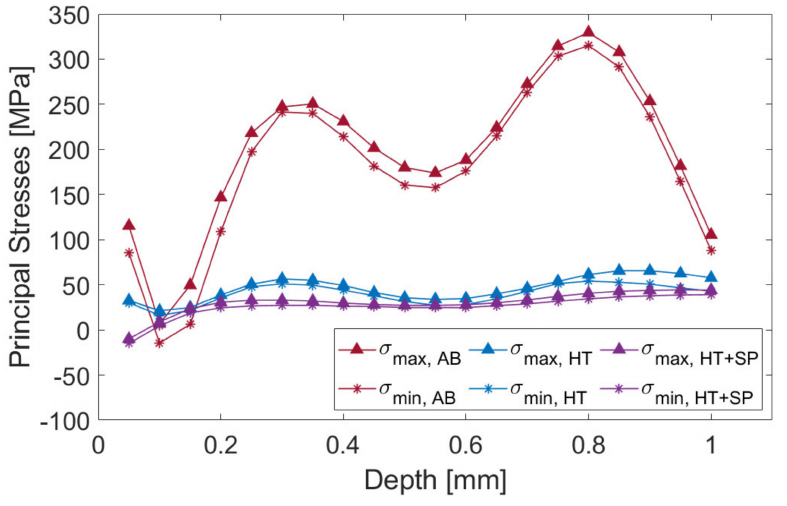
Figure 15. Values of residual stresses vs. distance from top surface of AlSi10Mg samples: as-built (AB), after heat treatments (HT) at 300 ◦ C for 3 h, and after heat treatment and shot peening (HT + SP). Redrawn from ref.